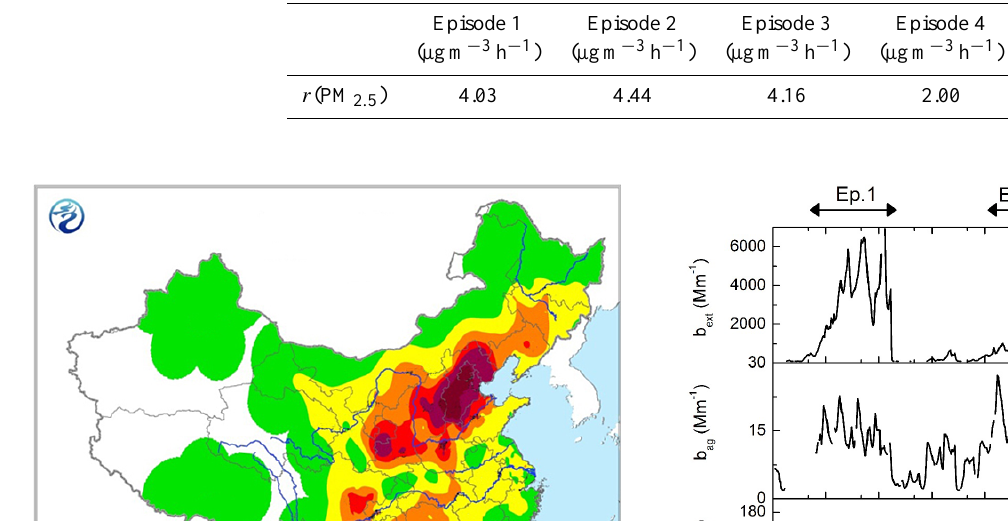
Table 2. The slopes of PM 2 . 5 concentrations during the four haze episodes (µgm − 3 h − 1 ).